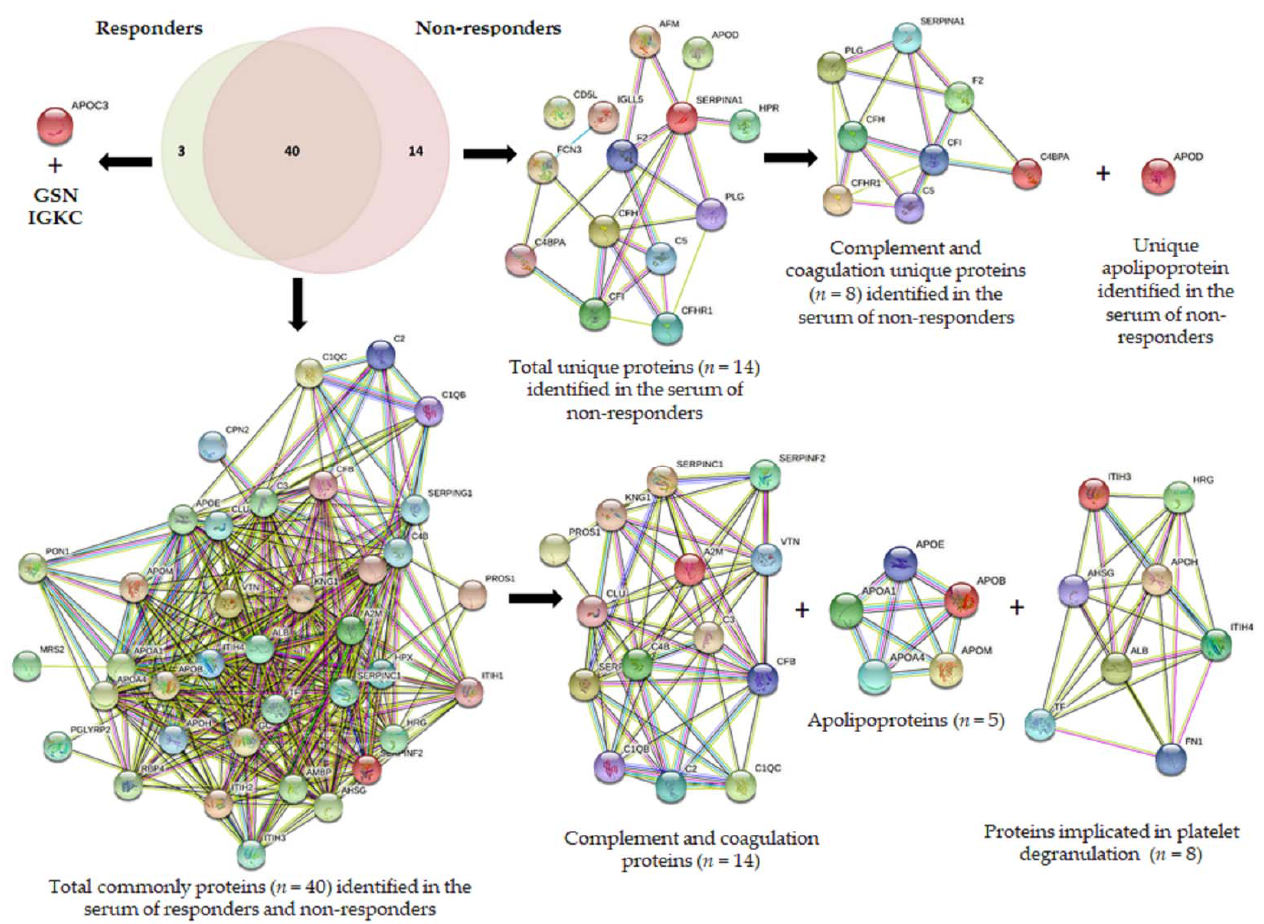
Figure 2. Venn diagram showing the number of proteins identified in the serum samples belonging to HER2-positive BC patients that were obtained before NAC. These patients showed a different response after the NAC treatment: responders ( n = 6), non-responders ( n = 4). Clusters found in the protein–protein interaction network map of the 43 and 54 genes encoded differentially proteins identified in serum samples from responders and non-responders before NAC, respectively. Based on the STRING database, a cluster of 14 proteins implicated in the complement and coagulation cascades were commonly identified in the serum of responders and non-responders (C1QB, C1QC, C2, C3, C4B, CFB, SERPINC1, SERPINF2, SERPING1, PROS1, VTN, A2M, CLU, KNG1), and a cluster of 8 proteins (C4BPA, C5, CFI, CFH, CFHR1, SERPINA1, F2, PLG) were specific to the non-responder’s group. Based on the STRING database, a cluster of 5 apolipoproteins were commonly identified in the serum of responders and non-responders (APOA1, APOA4, APOB, APOE, APOM), and APOC3 and APOD were specific of the responders and non-responders’ groups, respectively. A cluster of 8 proteins implicated in platelet degranulation (commonly identified in the serum of responders